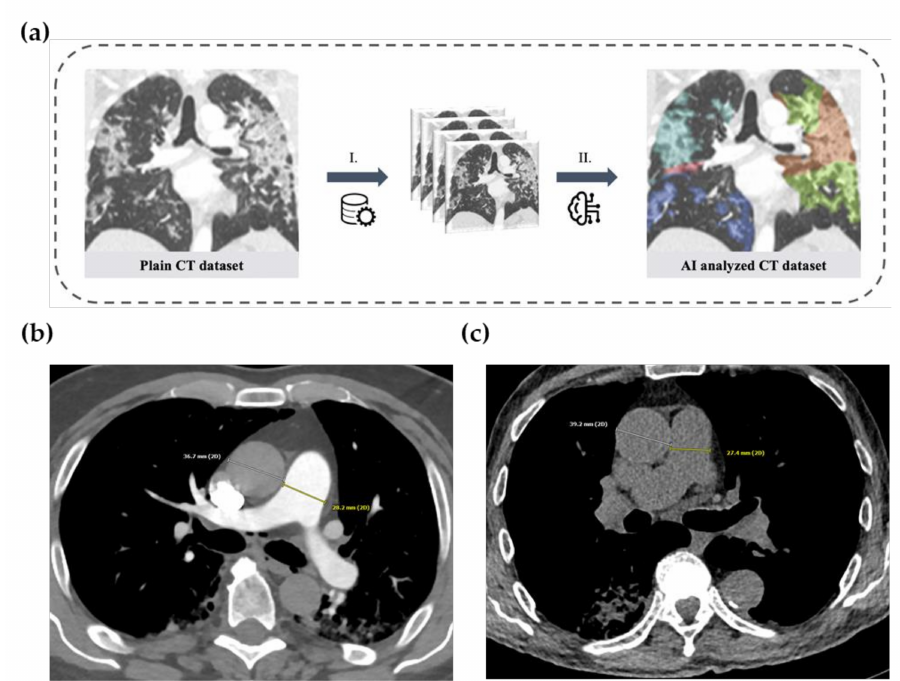
Figure 2. ( a ). CT scans of the thorax assessed with artificial intelligence: lung injury was quantified using a severity score ranging from 0 to 25. Left: Plain coronal slice image of the thorax CT scan in a patient with SARS-CoV-2 positive PCR test. Right: AI analyzed CT dataset with color staining of affected lung tissue (colored areas in each lung lobe). I. Pre-processing with data anonymization and uploading. II. AI-based analysis of CT dataset. ( b , c ). Measurements of the diameter of the ascending aorta (AA) and the pulmonary trunk (PA) close to the bifurcation in enhanced ( b ) and unenhanced ( c ) CT images for the calculation of the PA-to-AA